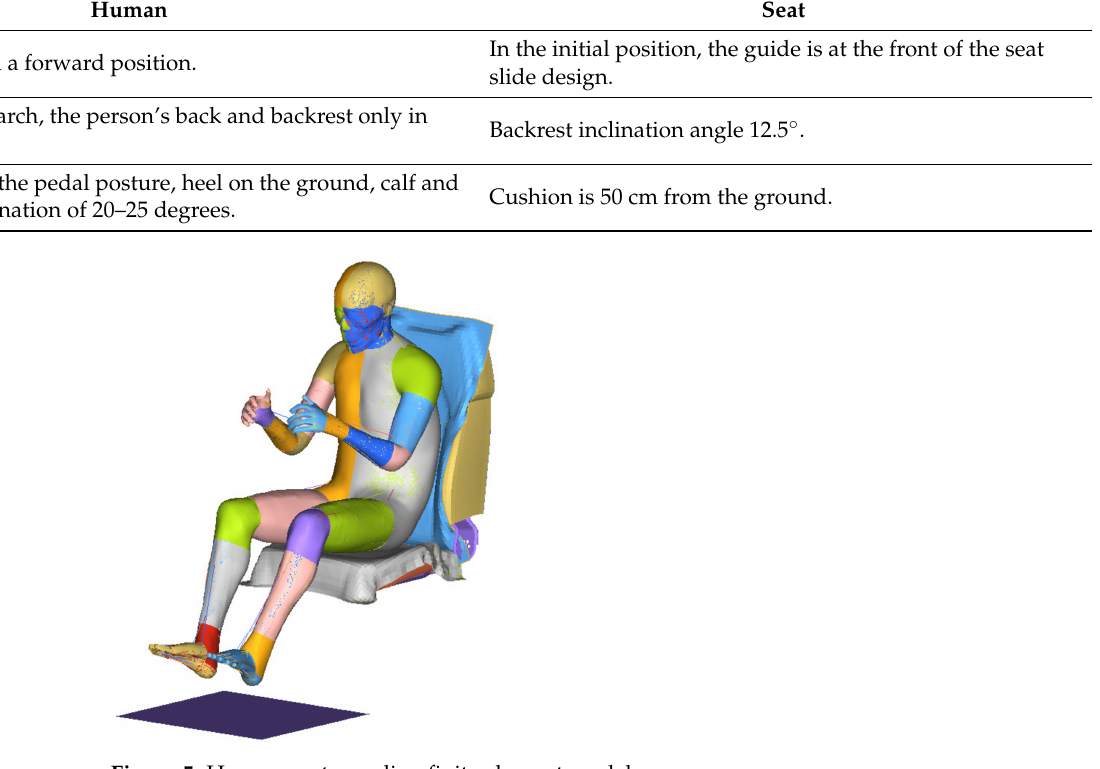
Figure 5. Human-seat coupling finite element